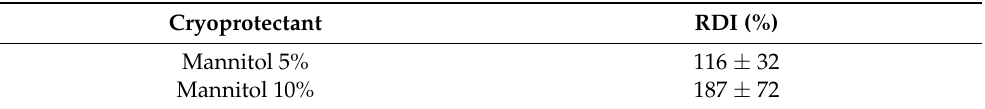
Table 2. RDI of the Zein_HA NPs after lyophilization with different cryoprotectants. Data are presented as mean ± standard deviation ( n =